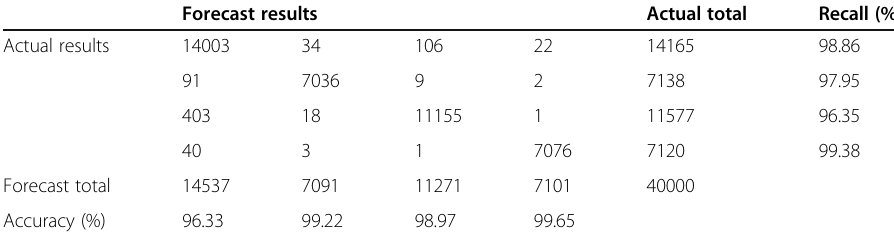
Table 4 Confusion matrix Forecast